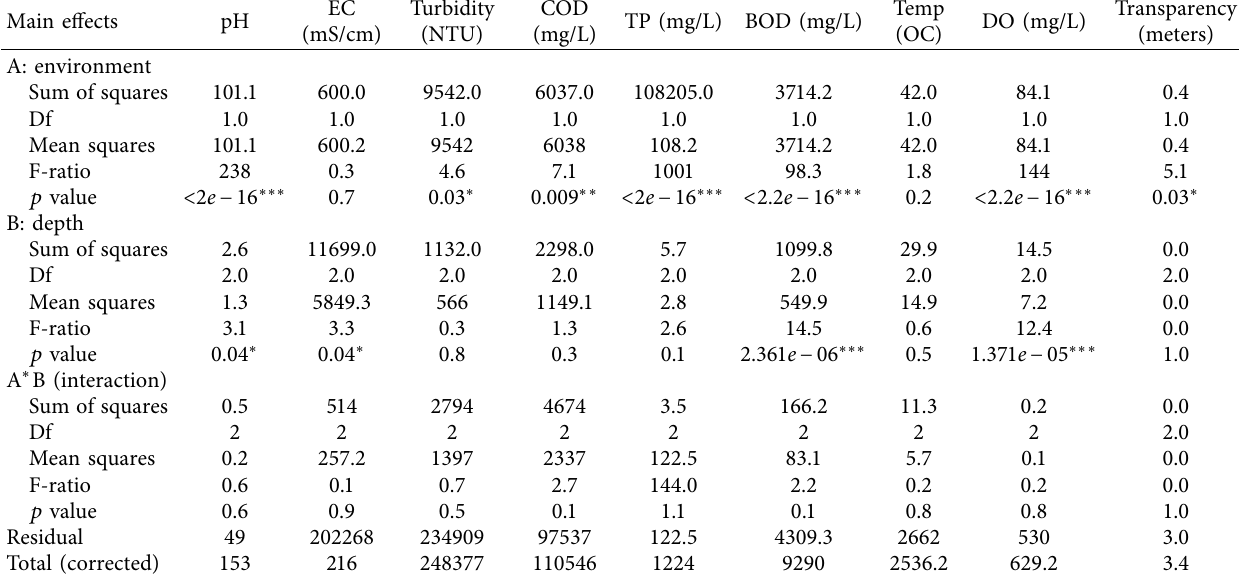
Table 5: Analysis of variance for physicochemical water properties: type III sums of